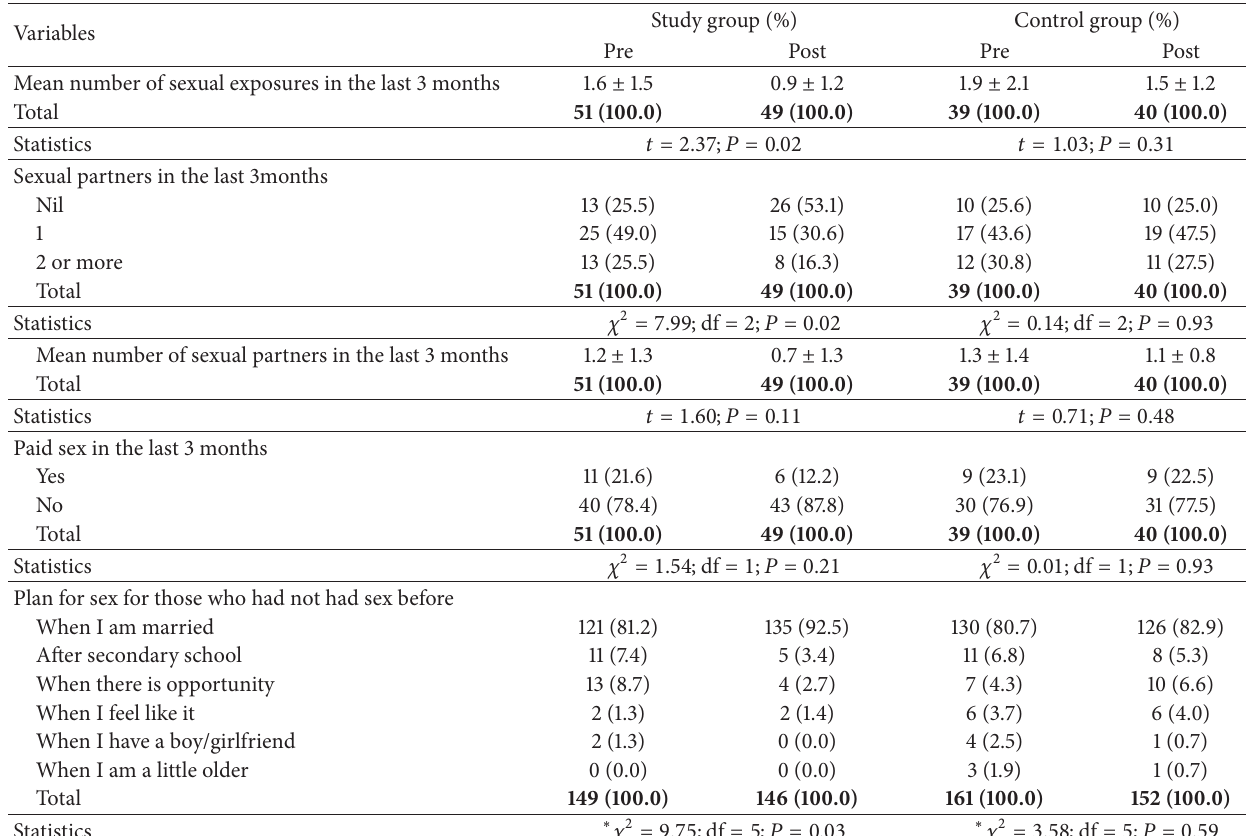
Table 6: Respondents’ sexual exposure at pre- and postintervention